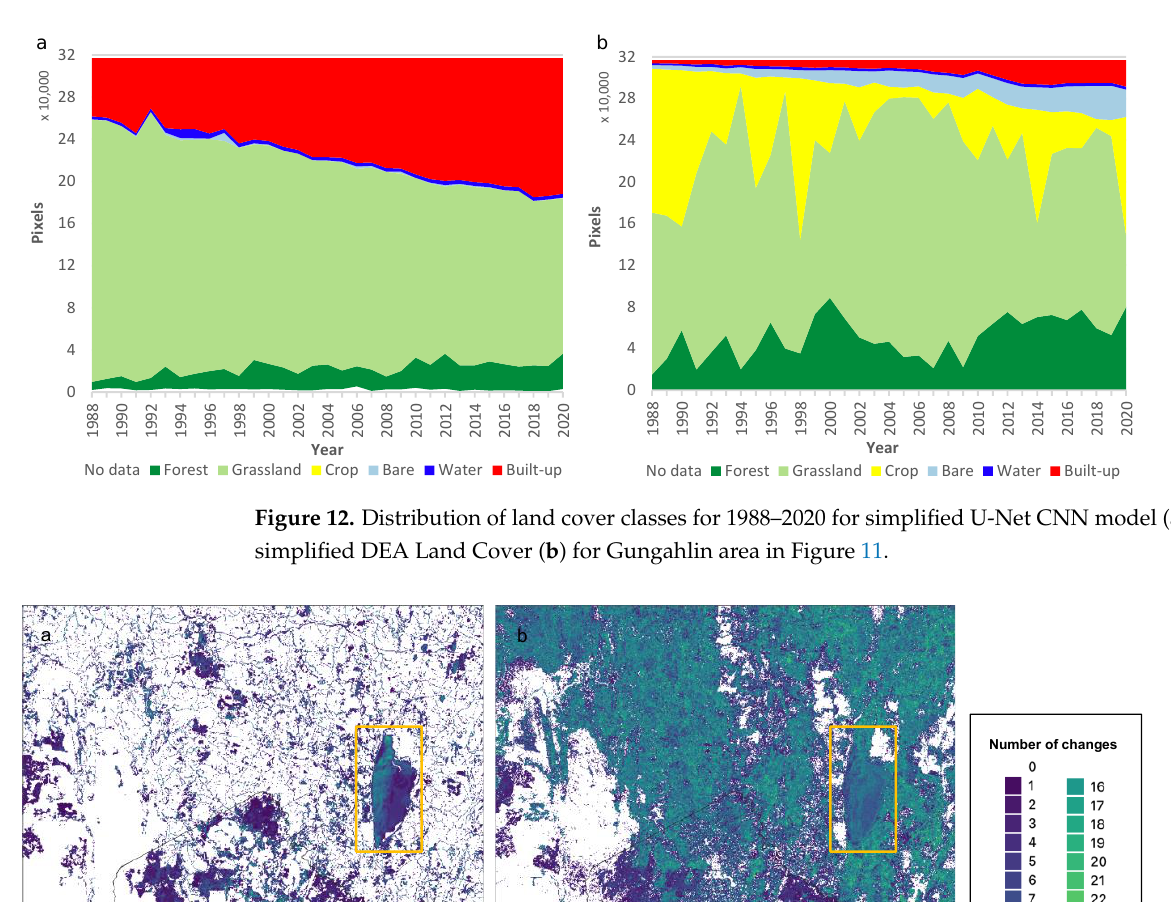
Figure 12. Distribution of land cover classes for 1988–2020 for simplified U-Net CNN model ( a ); and simplified DEA Land Cover ( b ) for Gungahlin area in Figure 11.